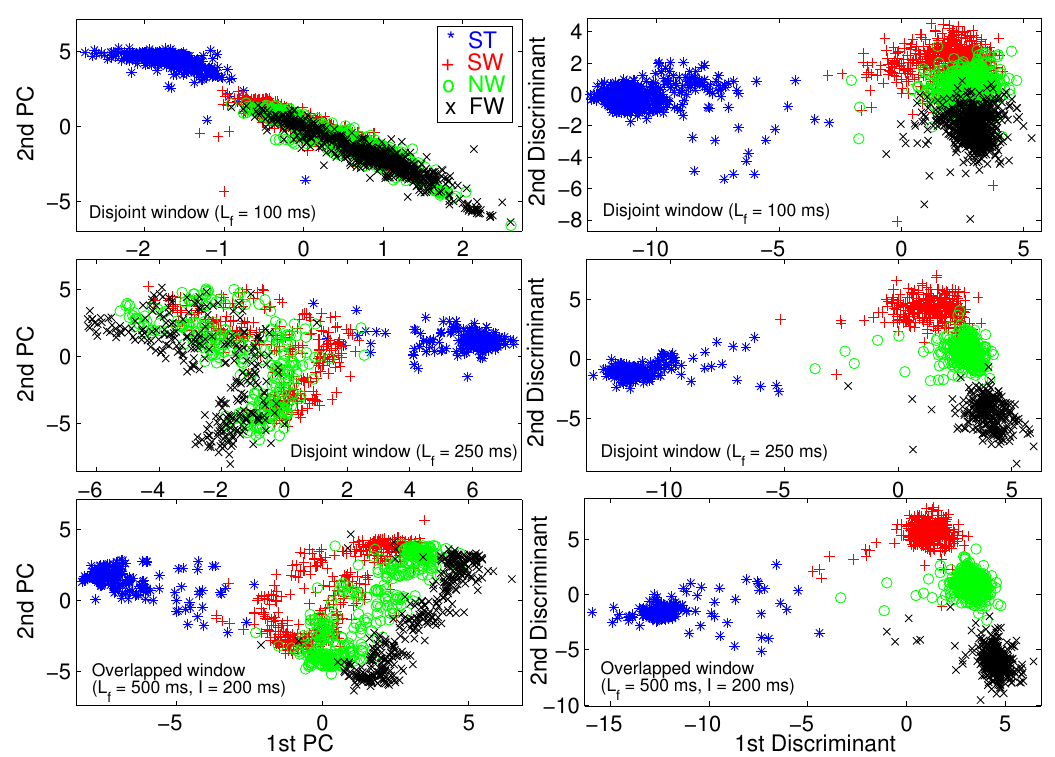
Figure 6. Two-dimensional scatter plot for visualization using principal component analysis (PCA) ( left column ) and Fisher linear discriminant analysis (FLDA) ( right column ) for able-bodied subject